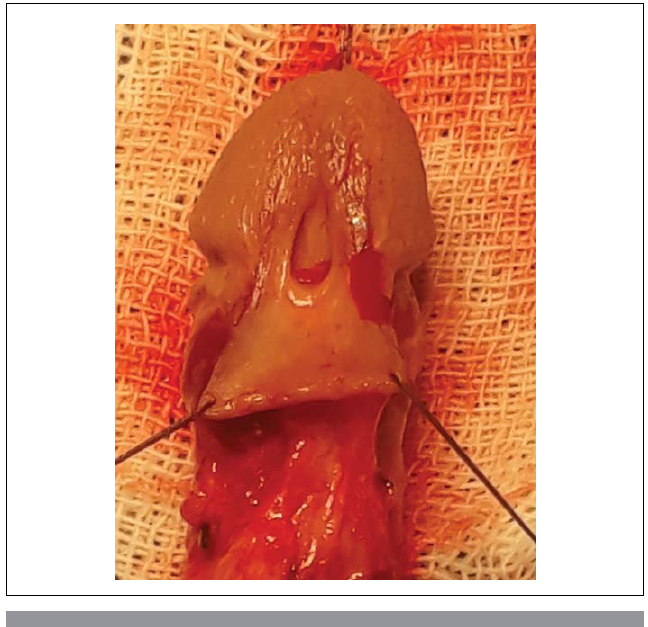
Figure 3. Raised Mathieu flap.